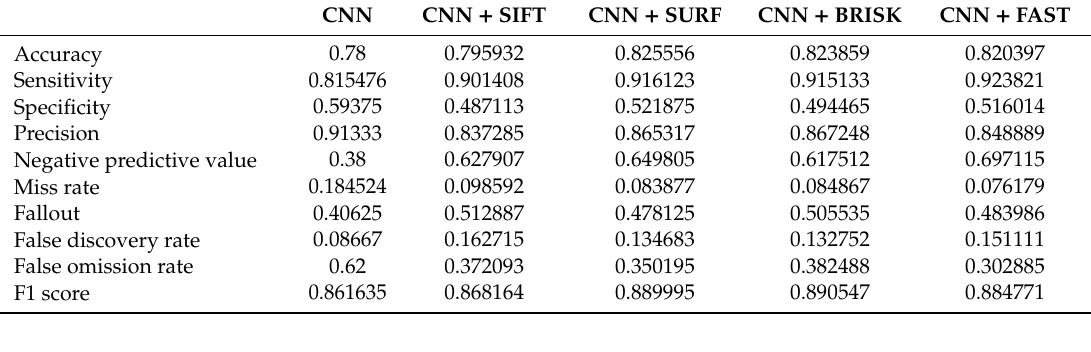
Table 4. Statistical coe ffi cients for classification measurements using the selected keypoint search algorithm with river metric and CNN.